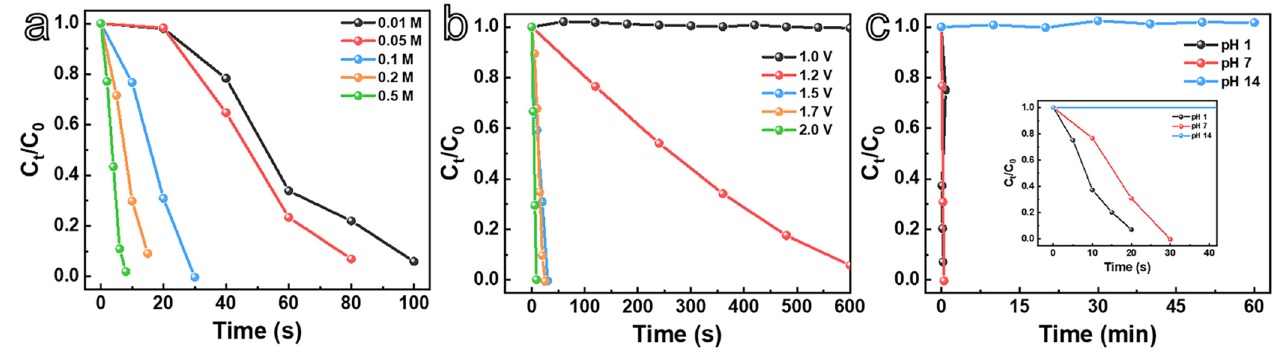
Figure 4. ( a ) The effect of the NaCl concentration on degradation performances of np ‐ Ni@NiO ‐ 4 (1.5 V applied potential, initial pH 7). ( b ) The effect of the applied potential on degradation performances of np ‐ Ni@NiO ‐ 4 (0.1 M NaCl concentration, initial pH 7). ( c ) The effect of the pH on degradation performances of np ‐ Ni@NiO ‐ 4 (0.1 M NaCl concentration, 1.5 V applied potential).